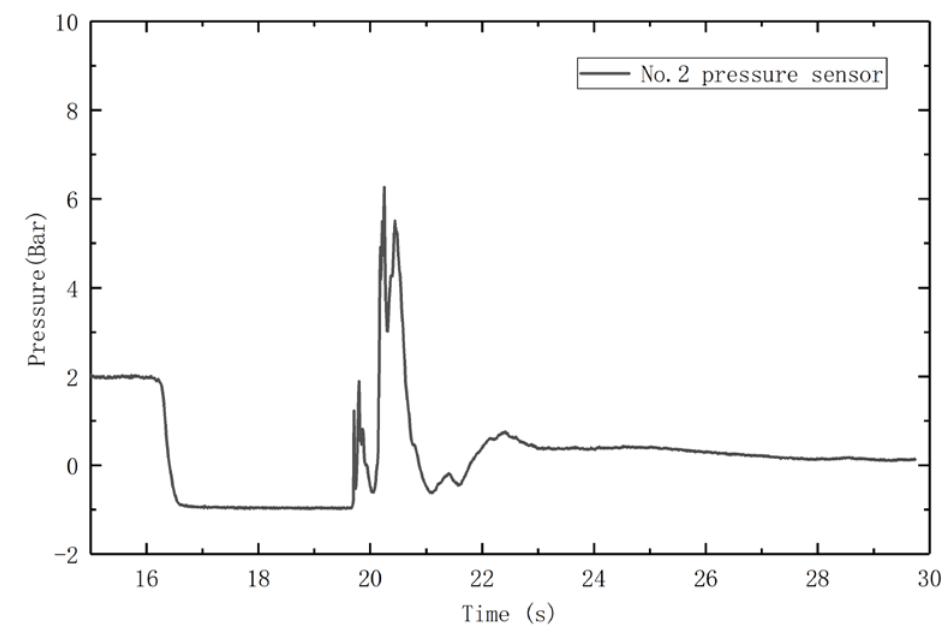
Figure 9. Instantaneous pressure of No. 2 pressure sensor.